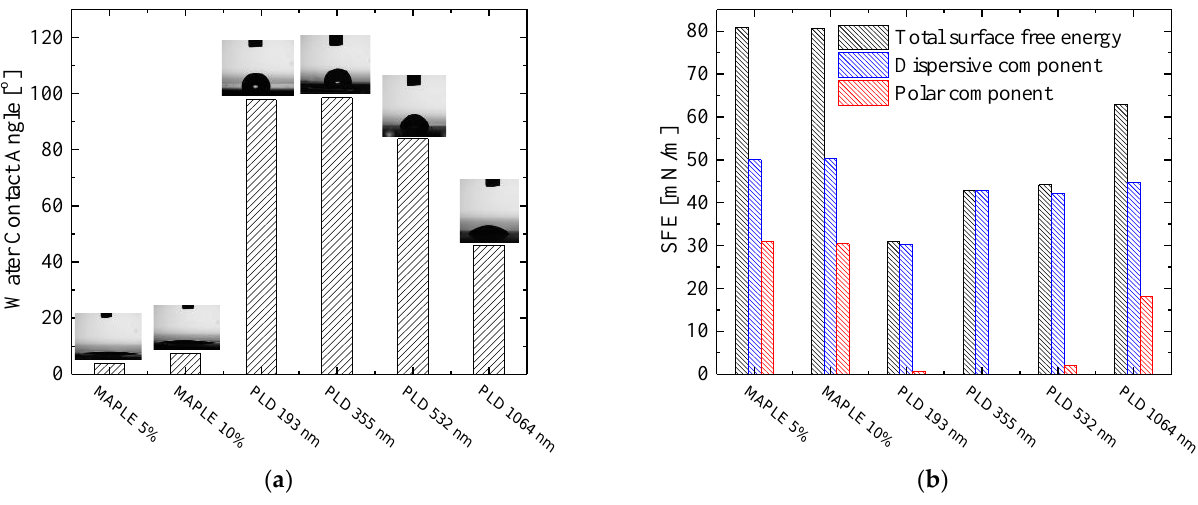
Figure 9. Contact angle (a) and surface energy components (b) for films deposited by MAPLE and PLD.